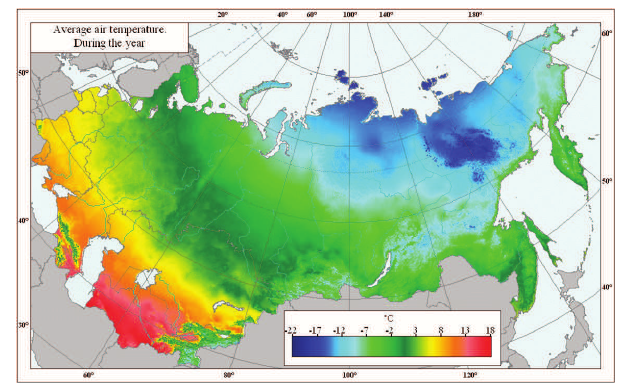
Fig. 1. Average air temperature during the year in Russia